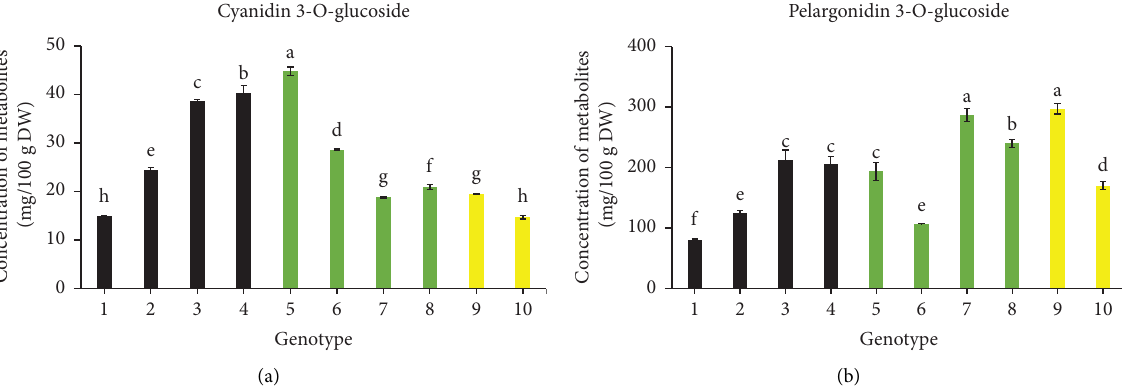
Figure 6: Te contents of anthocyanins in mungbean seed coats. (a) Cyanidin 3-O-glucoside and (b) Pelargonidin 3-O-glucoside. X and y axes indicate genotype and concentration of metabolites (mg/100 g DW), respectively. Te colors of each bar (black, green, and yellow) indicate the seed coat color. Te error bar indicates the standard deviation. Lowercase letters above the bar indicate statistical signifcance ( p < 0 . 05).